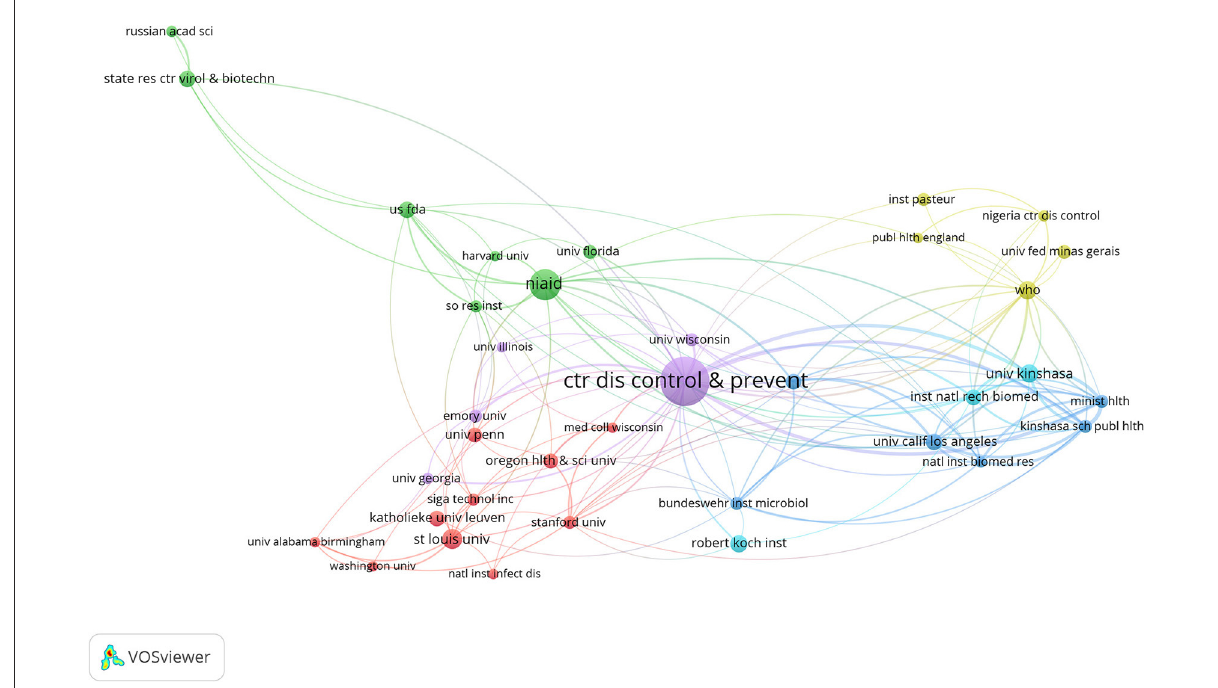
FIGURE9 Co-authorship overlay visualization map of institutions.